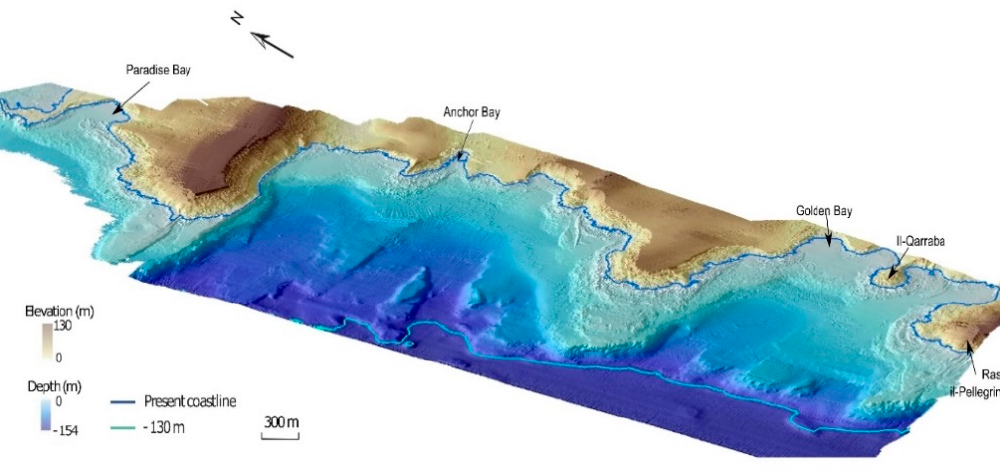
Figure 11. Integration of terrestrial and marine elevation data derived from bathymetric LiDAR: example from the NW coast of Malta, Central Mediterranean Sea (modified after Prampolini et al. [6]).